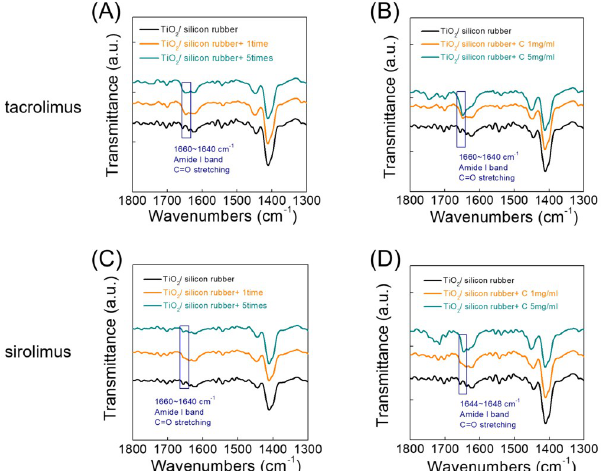
Fig 4. Change in transmittance of the drug-coated silicone plate according to the different coating conditions. (A) When tacrolimus (1 mg/ml) was repeatedly coated five times on the silicone plate, it had higher transmittance than single coated tacrolimus. (B) Tacrolimus coated at a higher concentration had higher transmittance. (C and D) The sirolimus-coated silicon plate showed the same properties.